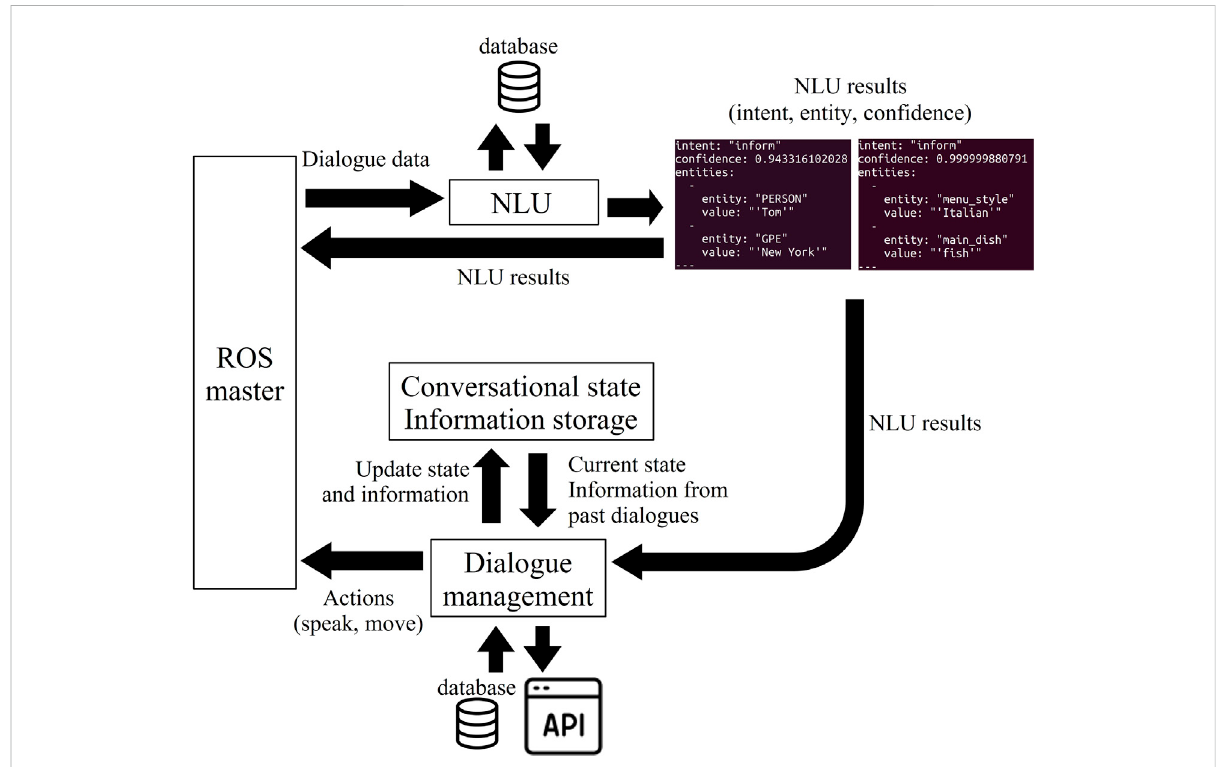
FIGURE 2 OverviewofthenaturallanguageprocessinganddialoguemanagementsystemusingRasaandROS.NLUresultsandthereactionsoftherobot are returned as rostopics. Modi fi ed from Fujii and Jokinen